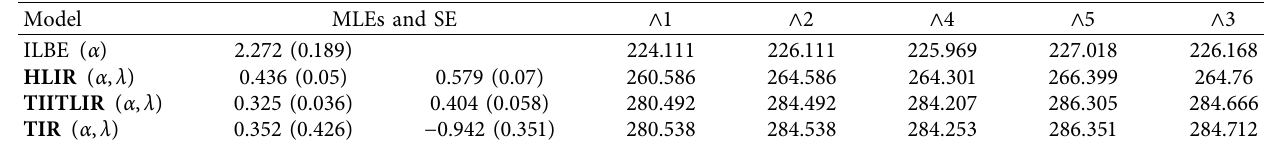
Figure 4: Fitted PDFs and CDFs of comparison models for the third dataset. Table 3: Numerical results of MLE, SE, ∧ 1 , ∧ 2 , ∧ 3 , ∧ 4 , and ∧ 5 for the first dataset.